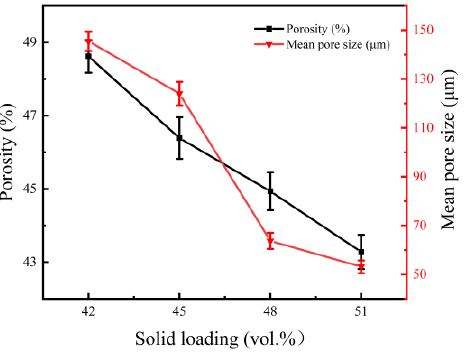
Figure 9. Influence of solid loading on the porosity and average pore dimeter of the sintered bodies.